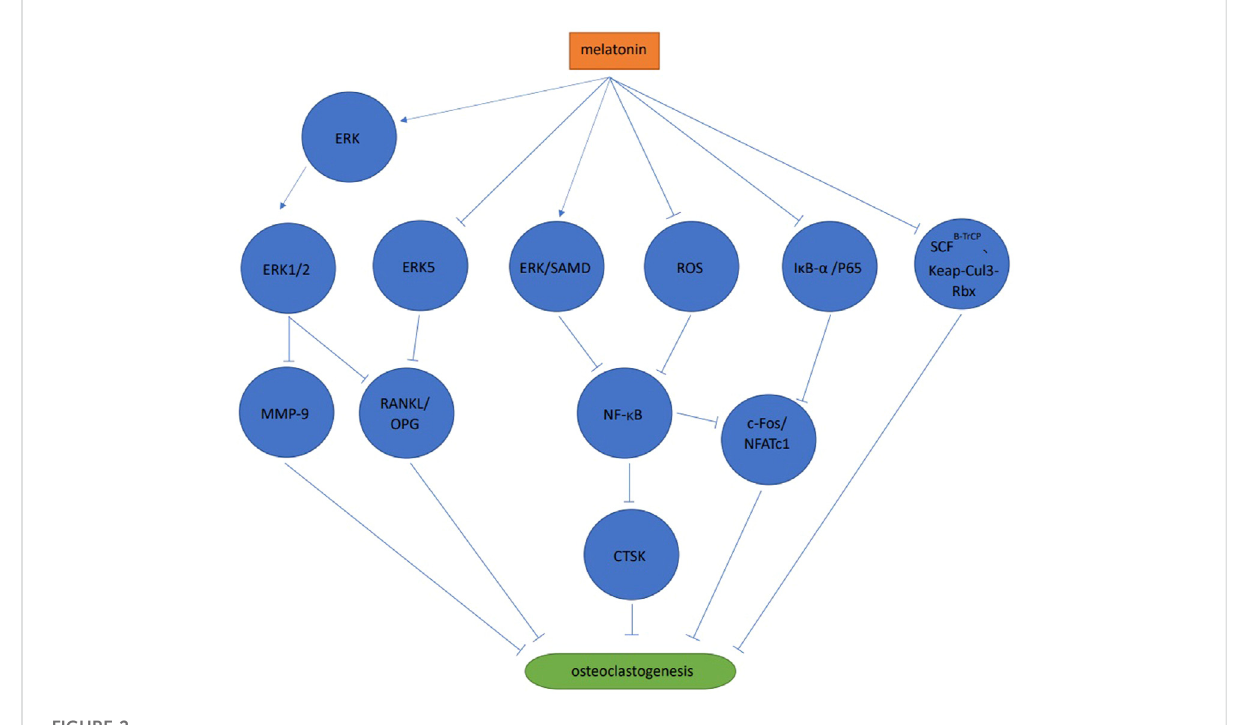
FIGURE 2 Signaling pathways of melatonin and osteoclast differentiation.